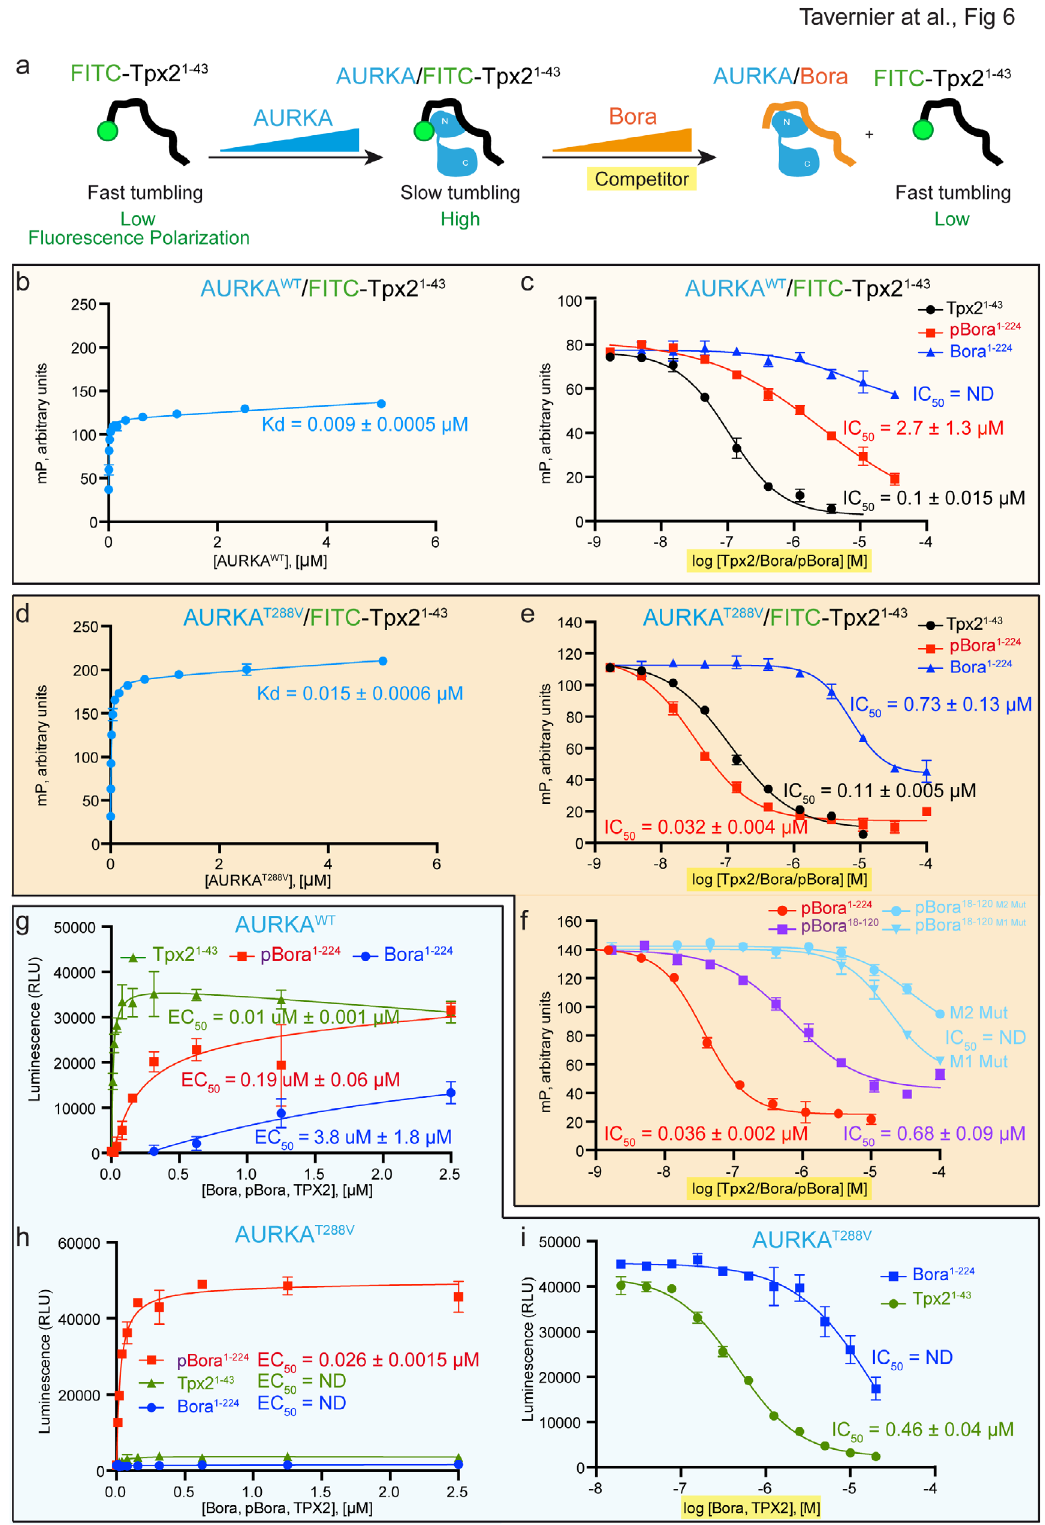
we previously showed that Bora 3A is defective in mitotic entry after checkpoint recovery from DNA damage 25,26 . Using this experimental setup, we examined mutant Bora function during the human cell cycle by combining endogenous Bora depletion upon Auxin addition with untagged Bora induction under Doxycyclin (D) (Fig. 9a and Supplementary Fig. 8a – c).